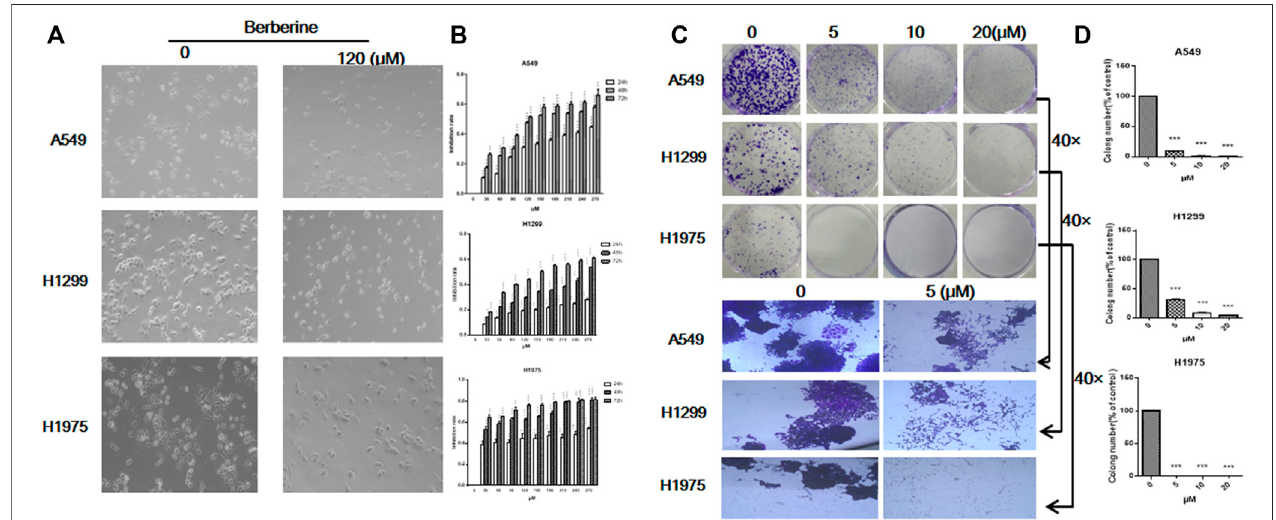
FIGURE 4 | Berberine inhibited the survival of NSCLC cells. (A) A549, H1299, and H1975 cells were treated with berberine (120 μ M) for 24 h, respectively. Photographs of cell morphology from a representative experiment are shown. (B) A549, H1299, and H1975 cells were treated with berberine (0, 30, 60, 90, 120, 150, 180, 210, 240, 270 μ M) for 24, 48, and 72 h, respectively, and cell viability was analyzed by the MTT assay. (C) A549, H1299, and H1975 cells were treated with berberine (0, 5, 10 and 20 μ M) and allowed to grow for an additional 10 days. Photographs of cell culture dishes from a representative experiment are shown. (B) Display of individual clone sizes (0 and 5 μ M). (D) Colony percentages represent the mean ± SEM from three individual experiments. * p < 0.05; ** p < 0.01; *** p < 0.001, compared with the control